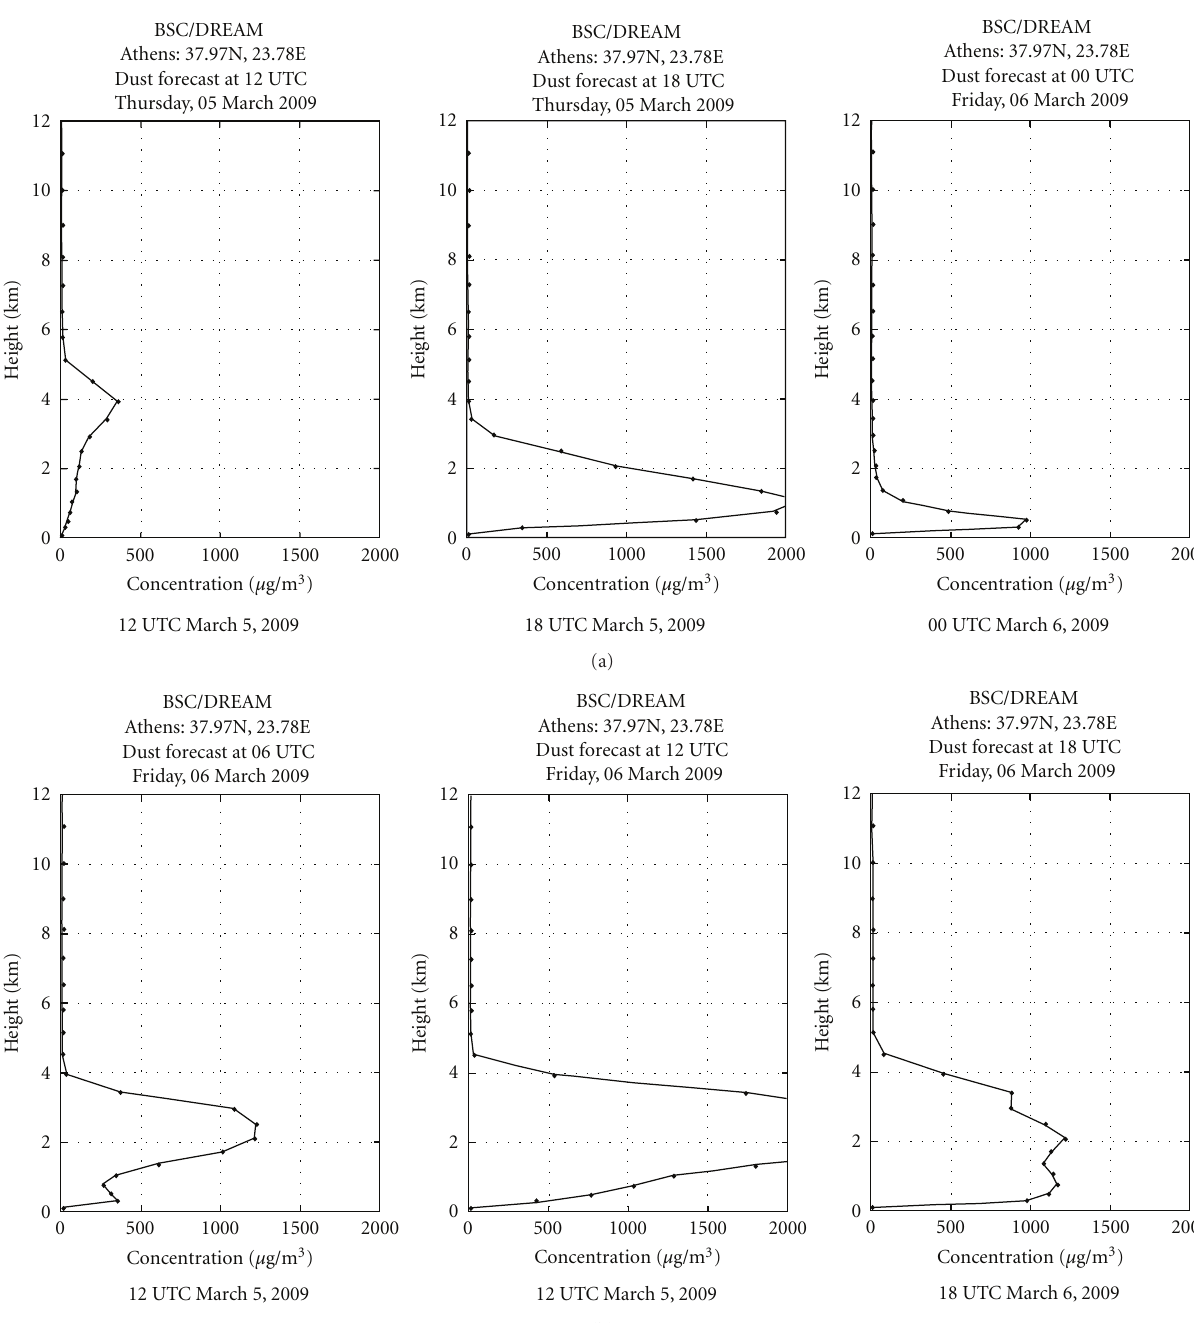
with its center firstly over Corsica in northern Tyrrhenian Sea and in the process over northern Italy (Figures 12(a) and 12(b)). This pattern combined with high pressure system on the surface at the south-east Libya, resulted in the prevalence of south air flow towards the region of Greece with gale winds ( ∼ 20 m/s) at 850 hPa level (Figures 13(a) and 13(b)) against violent storm winds (29–32 m/s) at 500 hPa level (Figures 13(c) and 13(d)) becoming hurricane winds